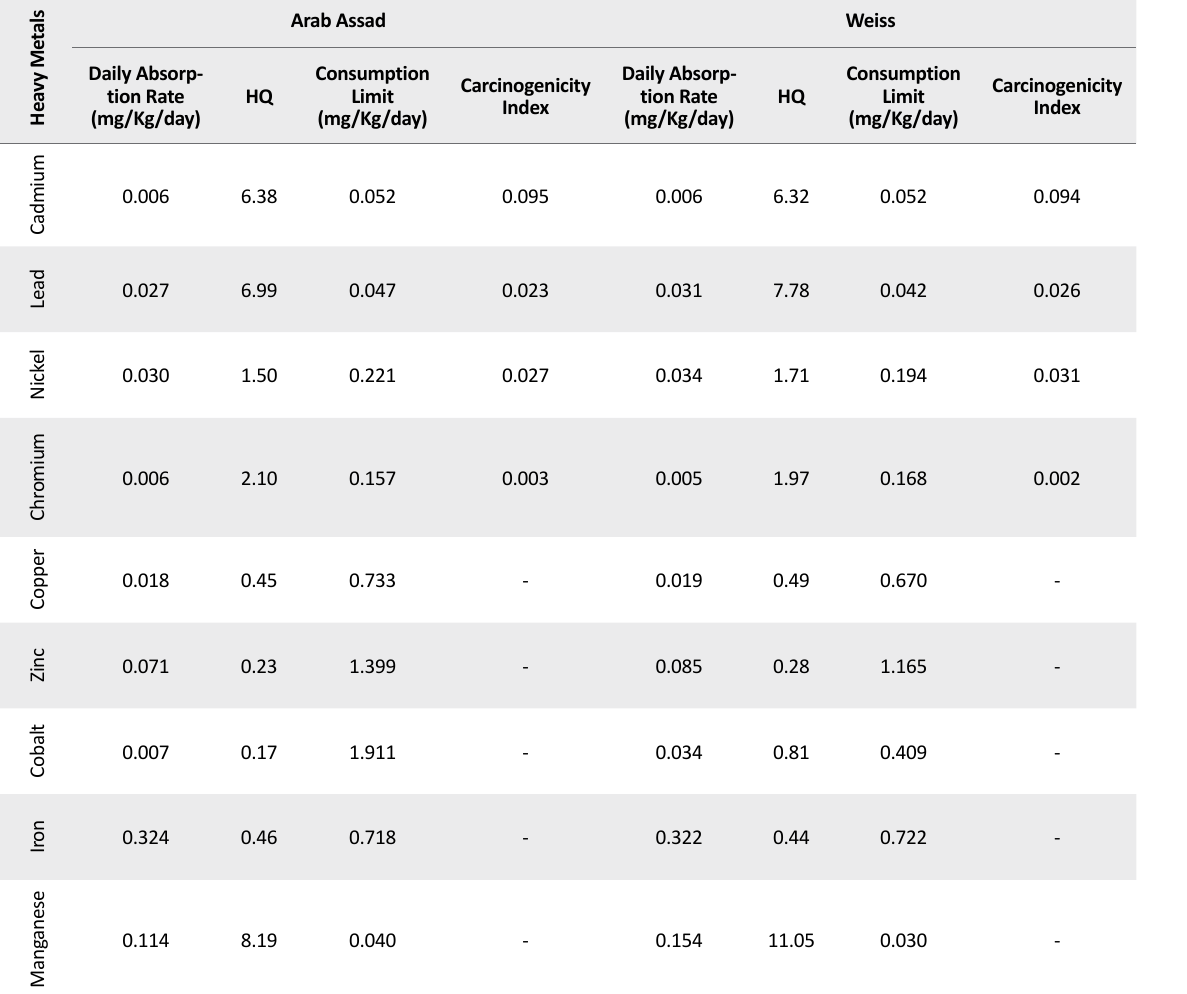
Table 8. Health risk assessment of heavy metals of wheat in farms of Weiss and Arab Assad regions in adults s Arab Assad Weiss a l e t M Daily Absorp- y tion Rate a v e (mg/Kg/day) H